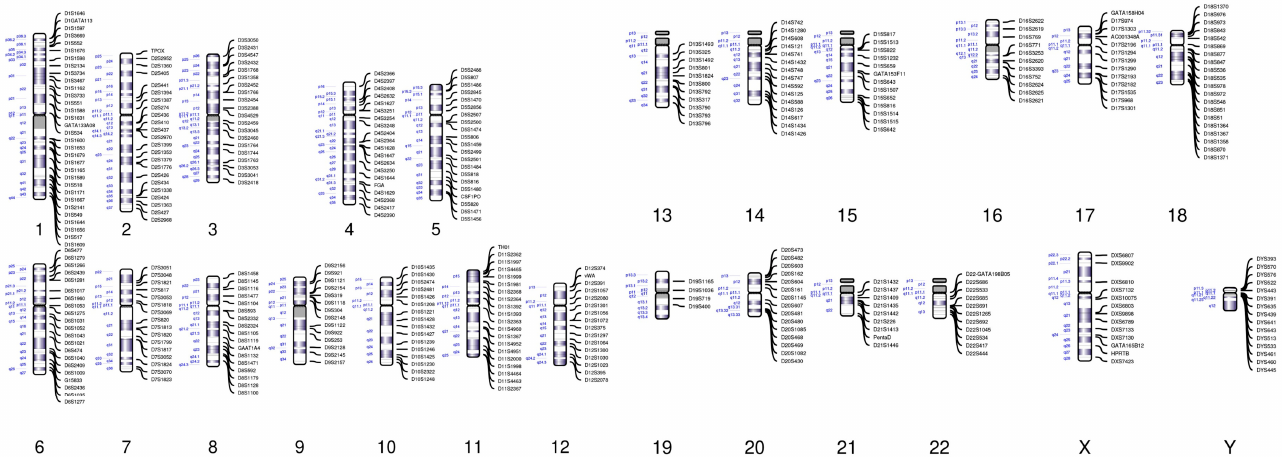
Figure 1. STR loci developed on each human